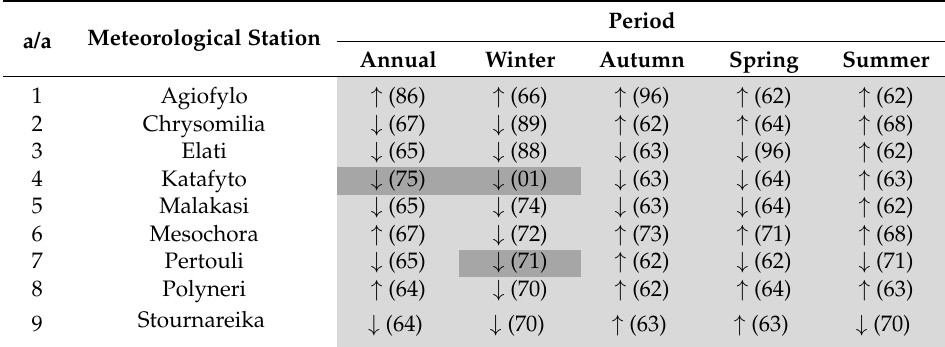
Figure 2. Seasonal distribution of rainfall. Table 3. Trend detection using the Mann–Kendall test and the change-point analysis.